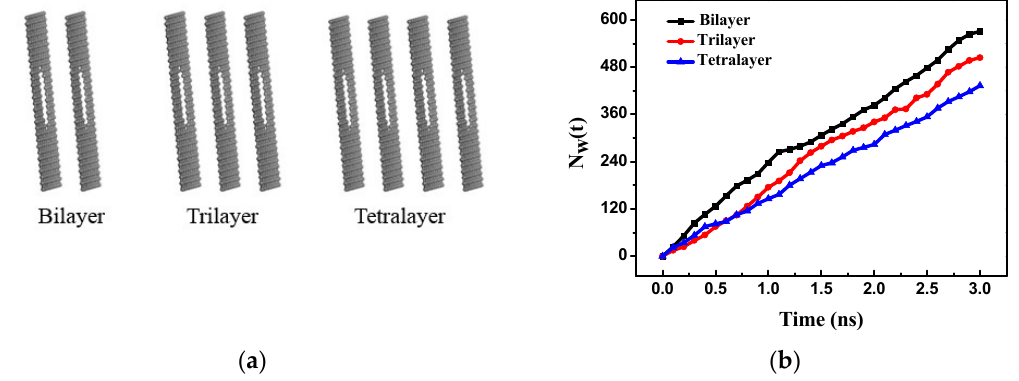
Figure 10. ( a ) Multilayer porous graphenes: bilayer, trilayer, and tetralayer; ( b ) the number of water molecules passing through multilayer porous graphene membranes versus time.